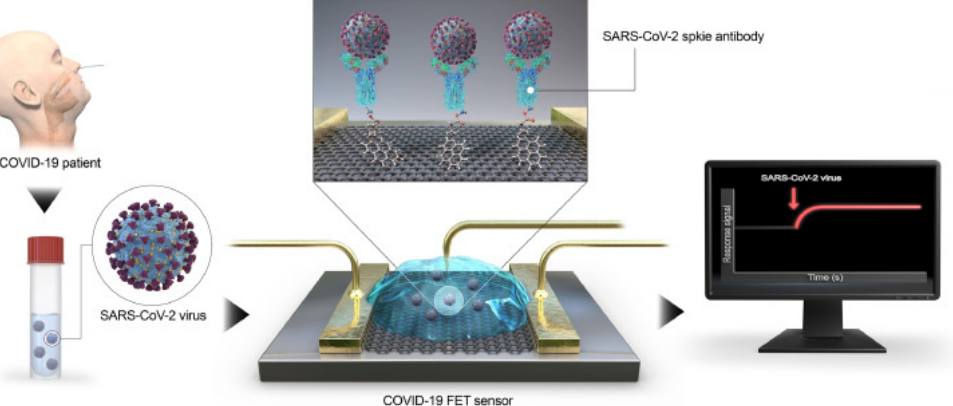
Figure 7. SARS-CoV-2 detection scheme using GFETError. Reprinted with permission from [224]. Copyright 2020, American Chemical